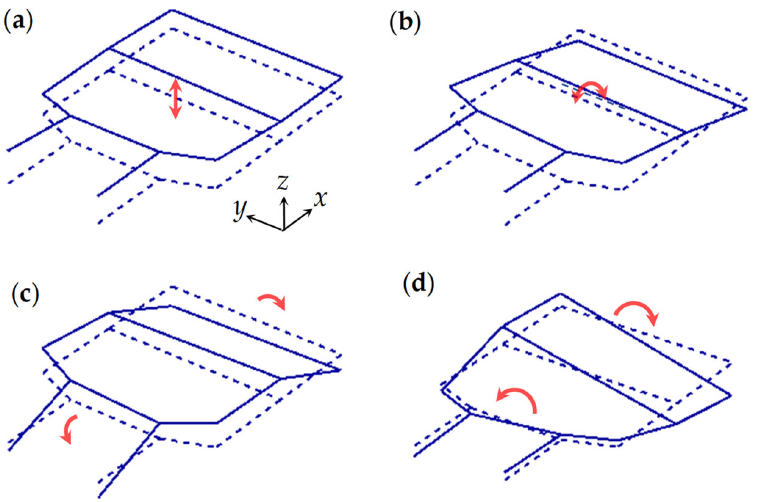
Figure 8. Mode shapes of the body floor: ( a ) bounce mode (3.2 Hz), ( b ) pitch mode (3.7 Hz), ( c ) bending mode (23.8 Hz), and ( d ) torsional mode (28.4 Hz).